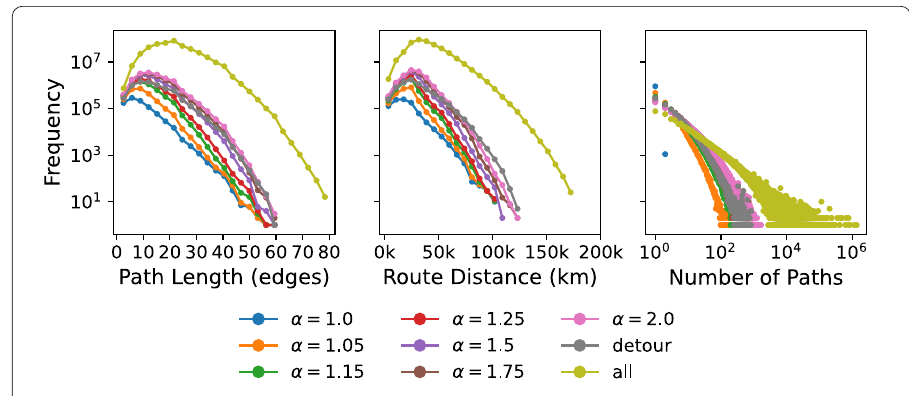
Figure 4 Outcome of filtering on minimum-route path statistics. Comparison of path length distribution (left), route shipping distance distribution (middle), and number of paths per pair (right) for all minimum-route paths against filtered paths with increasing values of the distance filtering parameter α , as well as the detour rate thresholding method. All filtering methods reduce the maximum values in each distribution and more paths are filtered when α is closer to 1. The parameterless detour rate thresholding method is more conservative than filtering using α < 1.75. We run subsequent analyses with α = 1.15,